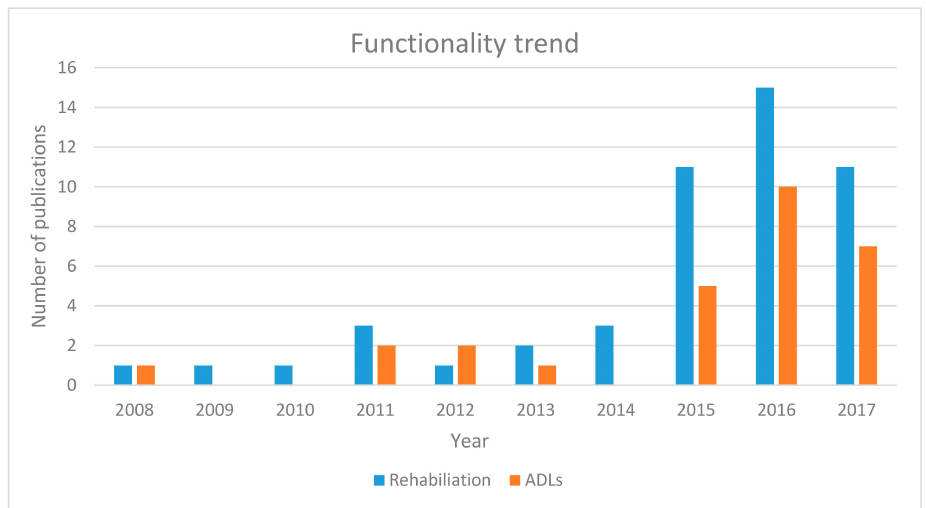
Figure 6. Functionality trend of soft robotic hand exoskeleton devices since